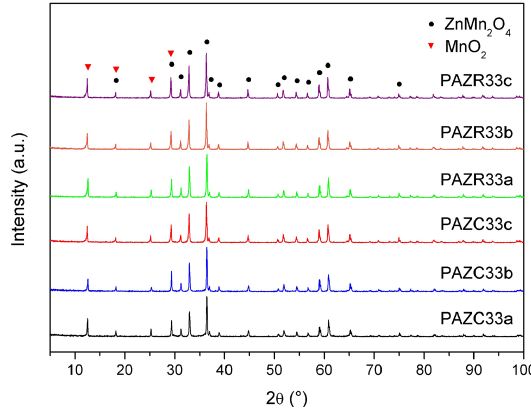
Figure 4. X-ray diffractogram of the PAZC33 and PAZR33 samples after heat treatment at 1200 °C. The a, b, or c indices in sample names refer to replicate